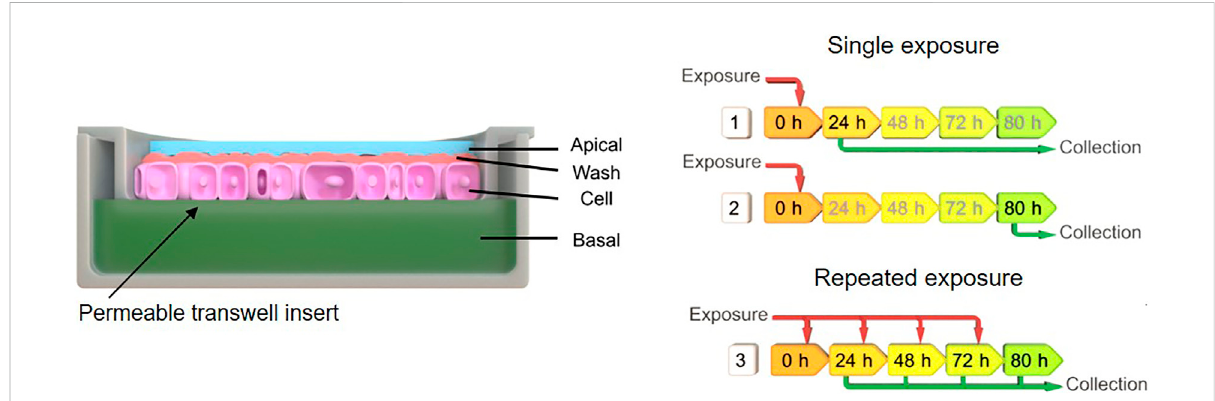
FIGURE 1 SchematicindicatingtheexposurescenariosandsamplecollectionaftermaterialexposurestoA549monolayer.Exposurescenariooneimplies single exposure (100 µg/ml) at time point zero and sample collection after 24 h, for scenario two single exposure (100 µg/ml) at time point zero and sample collection after 80 h, and scenario three repeated exposure (25 µg/ml) and multiple collection after 24, 48, 72, and 80